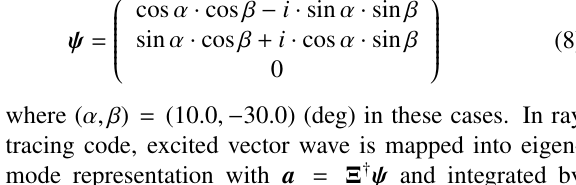
Figure 4. Calculation results of 1DFW in cold plasma slab with a magnetic field shear period (cid:28) s = 0 : 25. (a) - (e) have the same meaning with Fig.